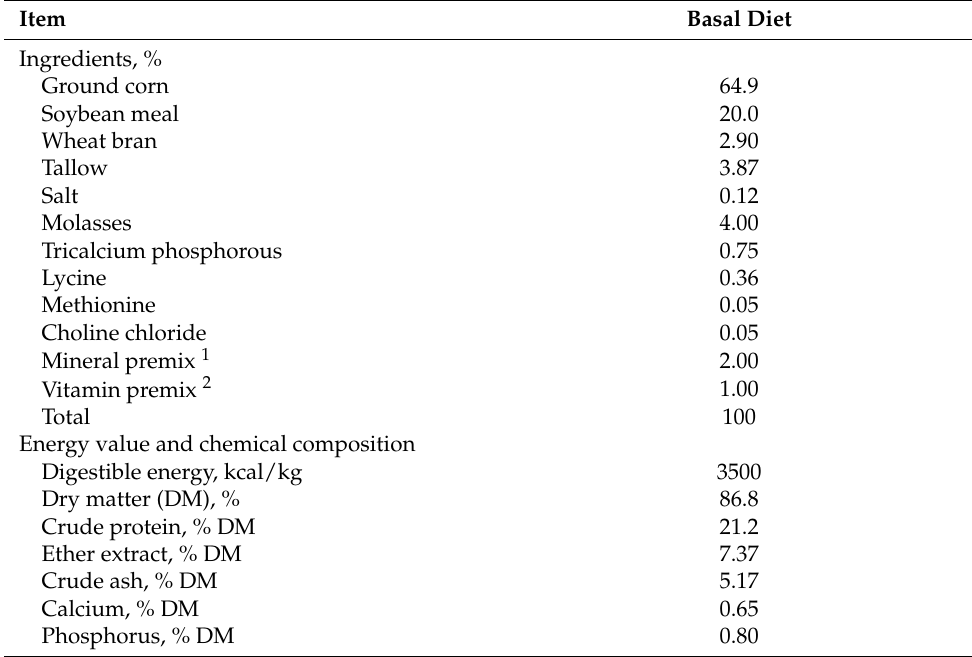
Table 2. Ingredients and chemical compositions of the basal diet fed from 21 to 42 d of